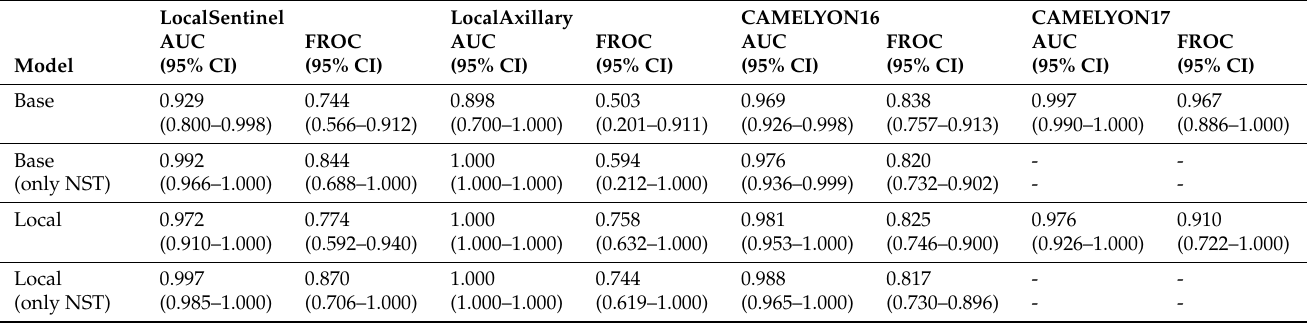
Table 4. Results for base model and local model on defined testset with AUC and FROC. Metrics were calculated individually on each dataset. The second and fourth row show the results for datasets containing only NST